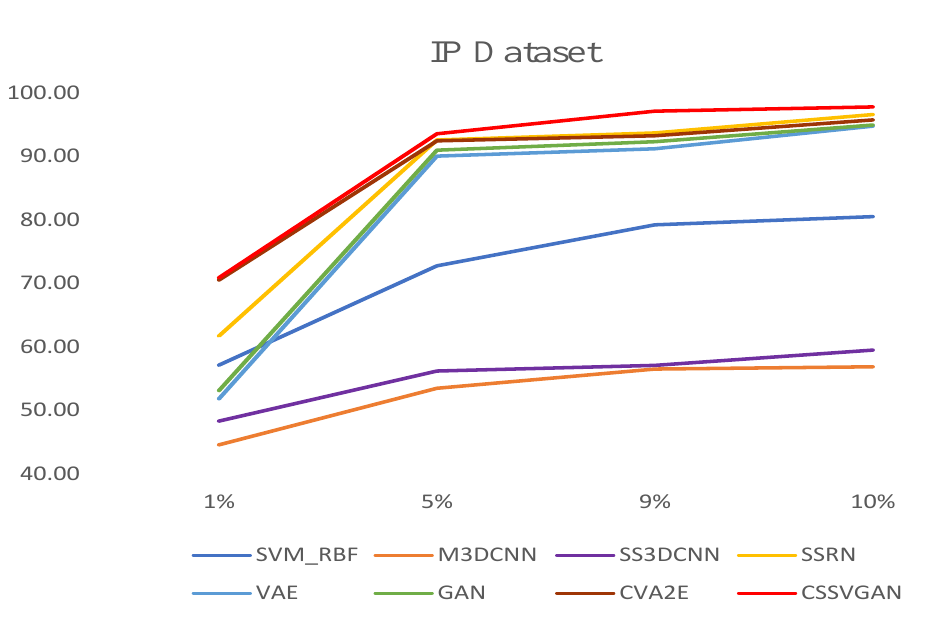
Figure 14. Sensitivity to the Proportion of Training Samples in IP dataset.